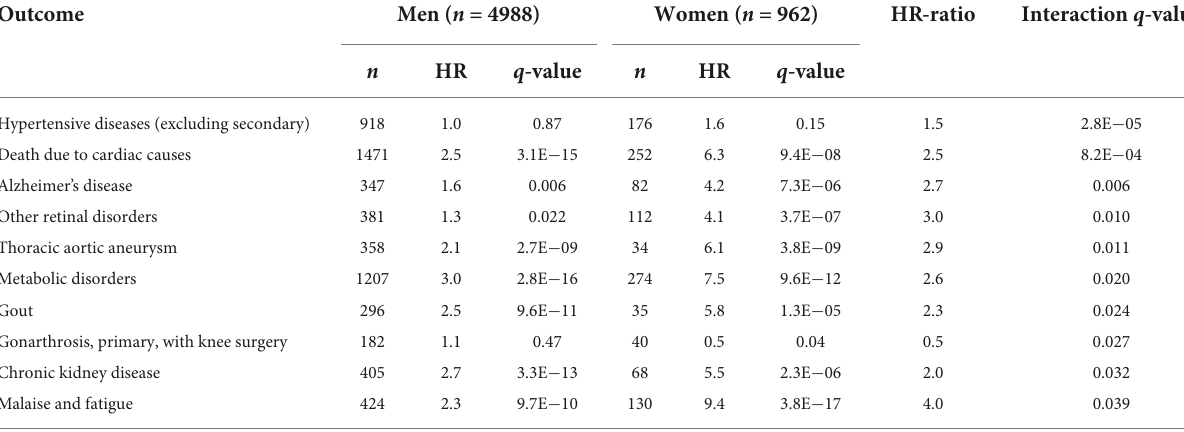
TABLE 2 Association of CABG and incident outcomes by